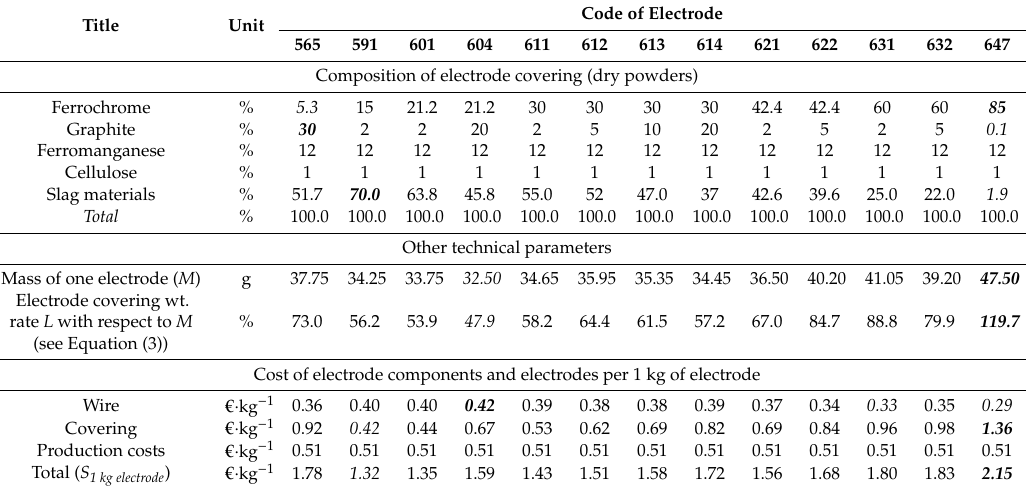
Table 2. The composition of the electrode covering, the technical parameters of electrode production, costs of electrodes, and its components (according to data from the company).